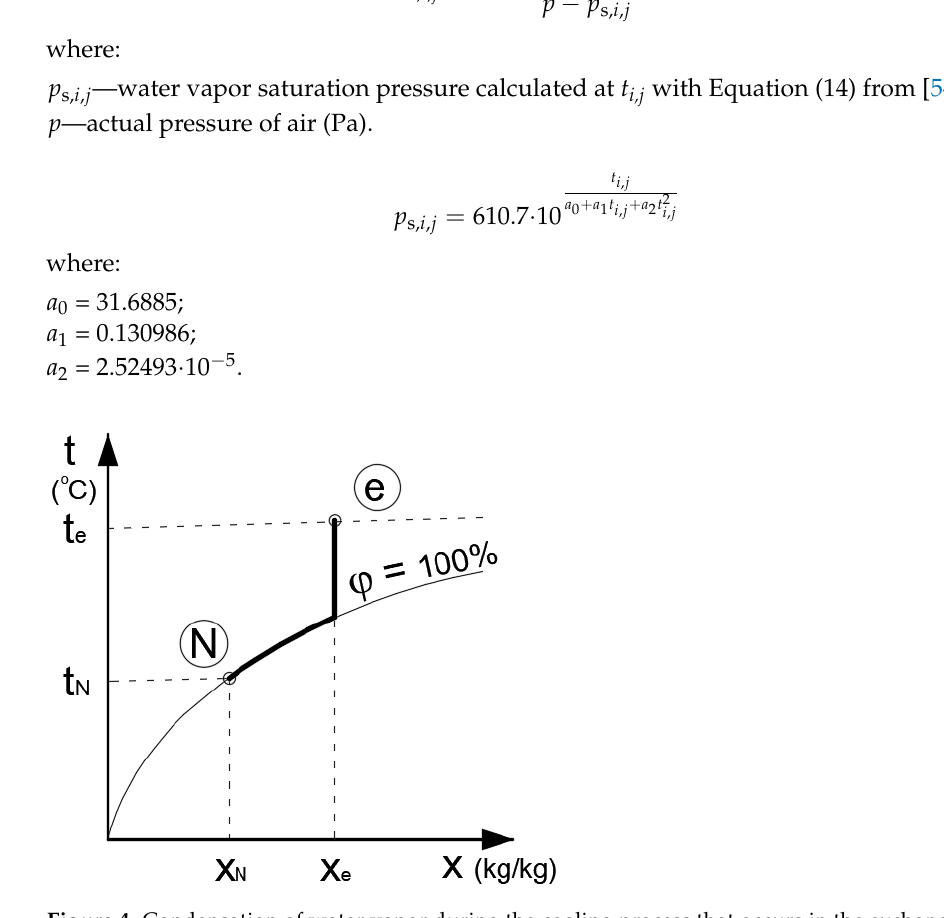
Figure 4. Condensation of water vapor during the cooling process that occurs in the exchanger pipes in the summer, previously presented in the authors’ earlier work [50].